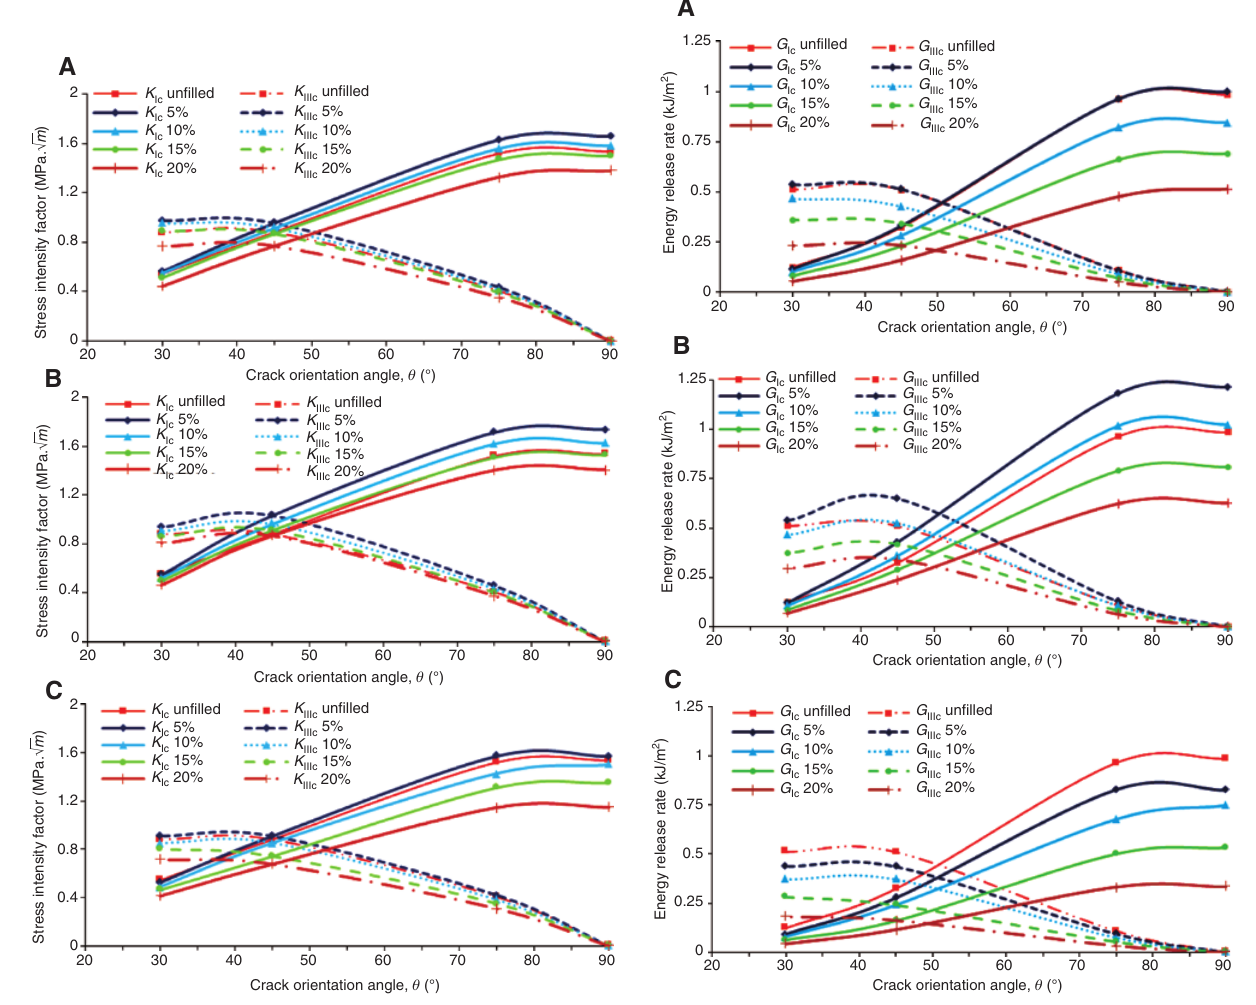
Figure 9: Mode I and mode III critical energy release rate of (A) SSA, (B) FA, and (C) SiC filled polyester